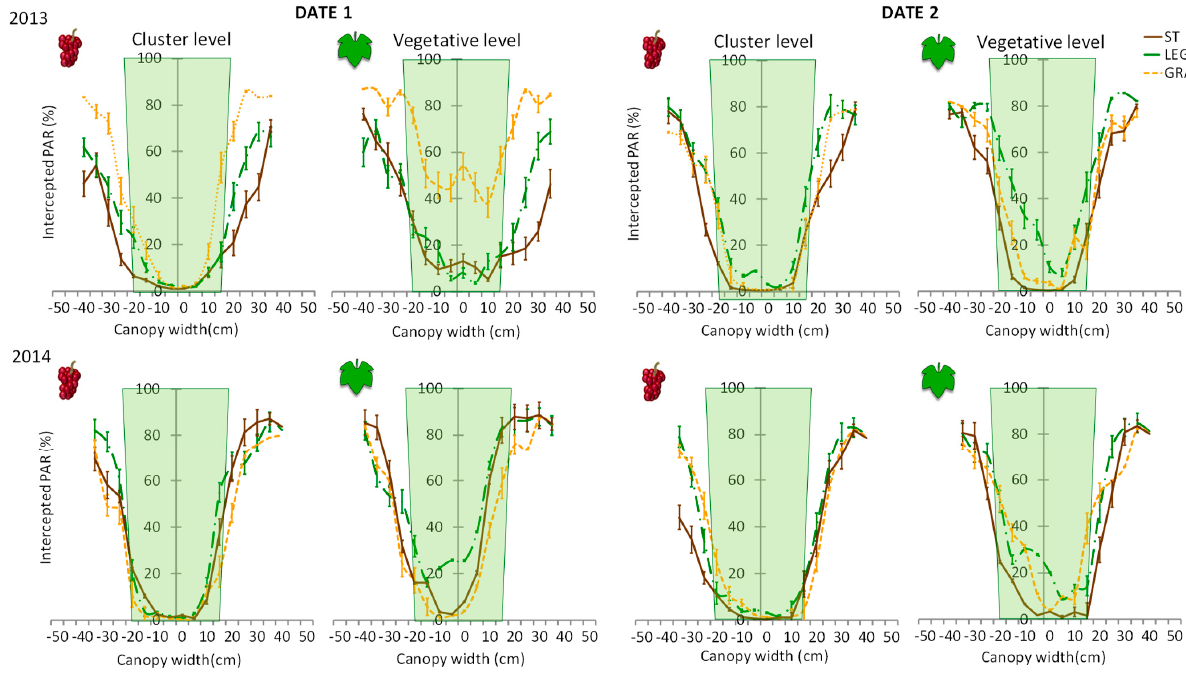
Figure 9. Transversal profiles of the intercepted PAR during mid-day, at the cluster level and at an upper vegetation level, measured in the three soil management treatments close to date 1 and 3 of the disease observations in shoots in seasons 2013 and 2014. Values are the mean ± standard error.